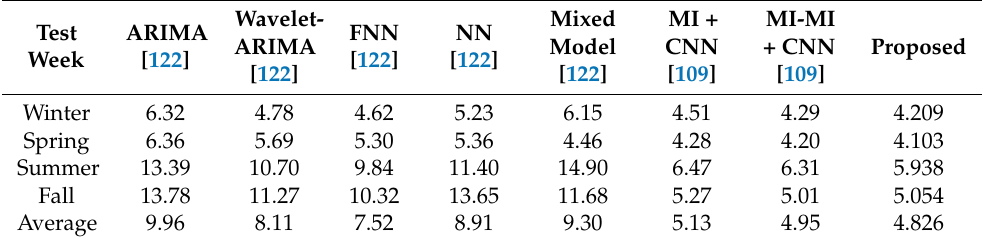
Figure 11. Simulation results for Spain’s system for the 168 h period; continuous blue line (the real value) and the dotted red line (the forecast value). Table 3. Proposed and other models presented on basis of the weekly MAPE criterion for four weeks in Spain’s